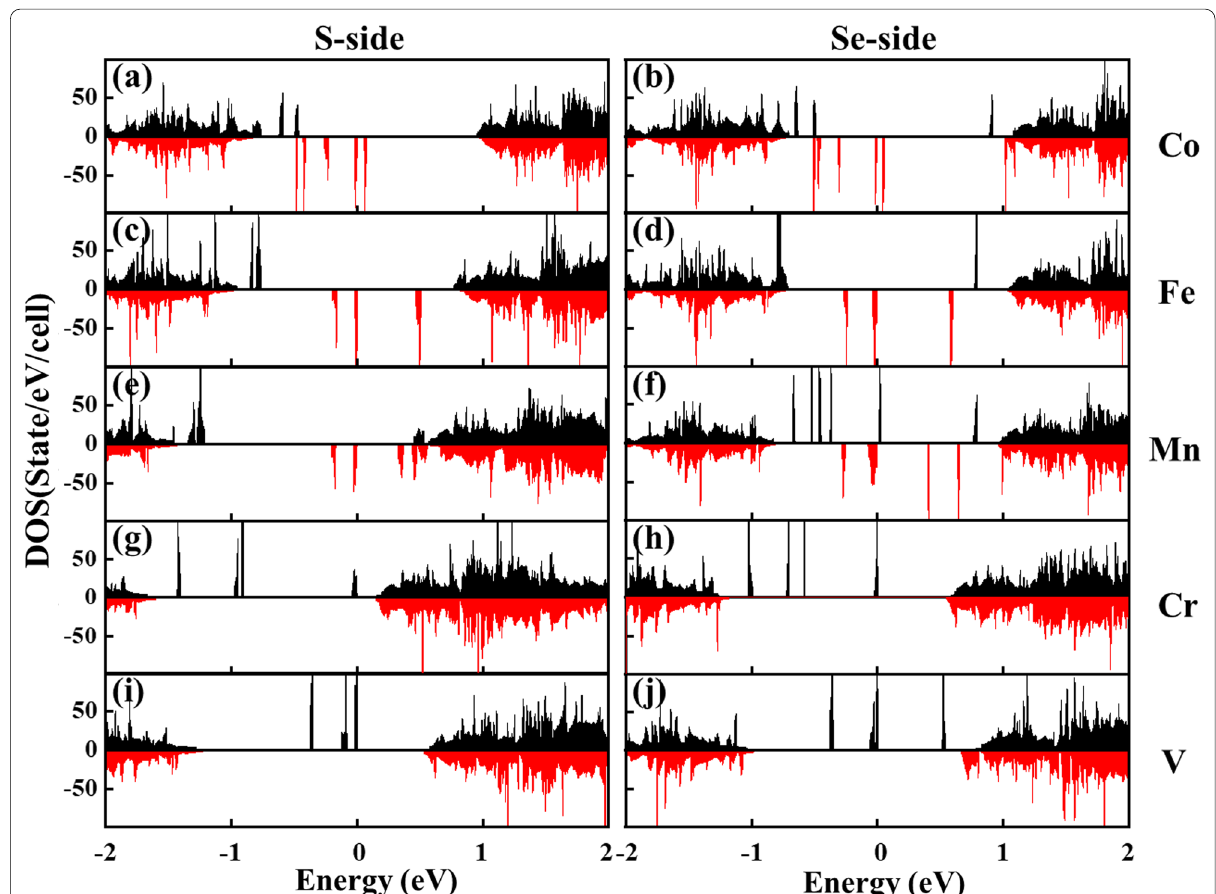
Fig. 3 Spin-polarized total DOS of the different TM atom-adsorbed WSSe monolayer. a , b Co; c , d Fe; e , f Mn; g , h Cr; i , j